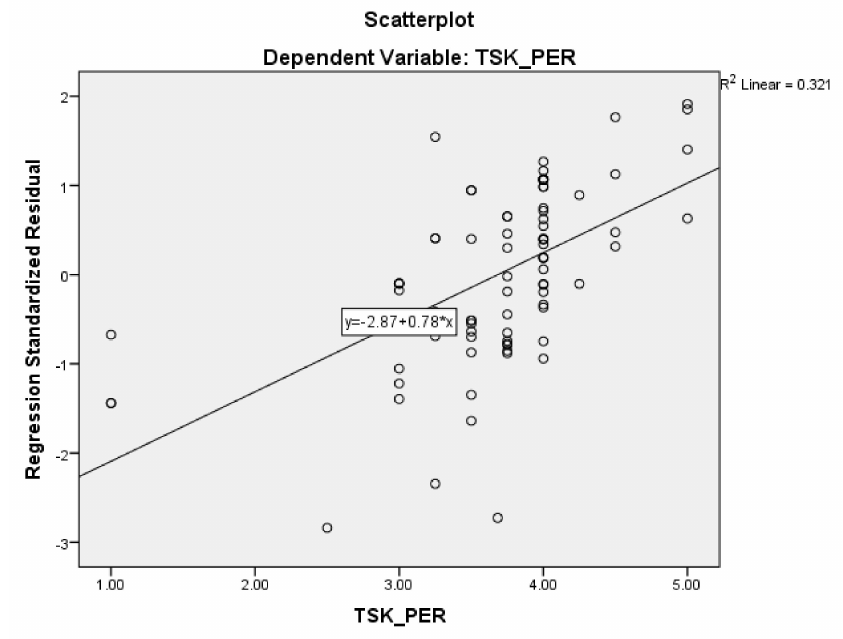
Figure 8. Regression standardized predicted values versus regression standardized